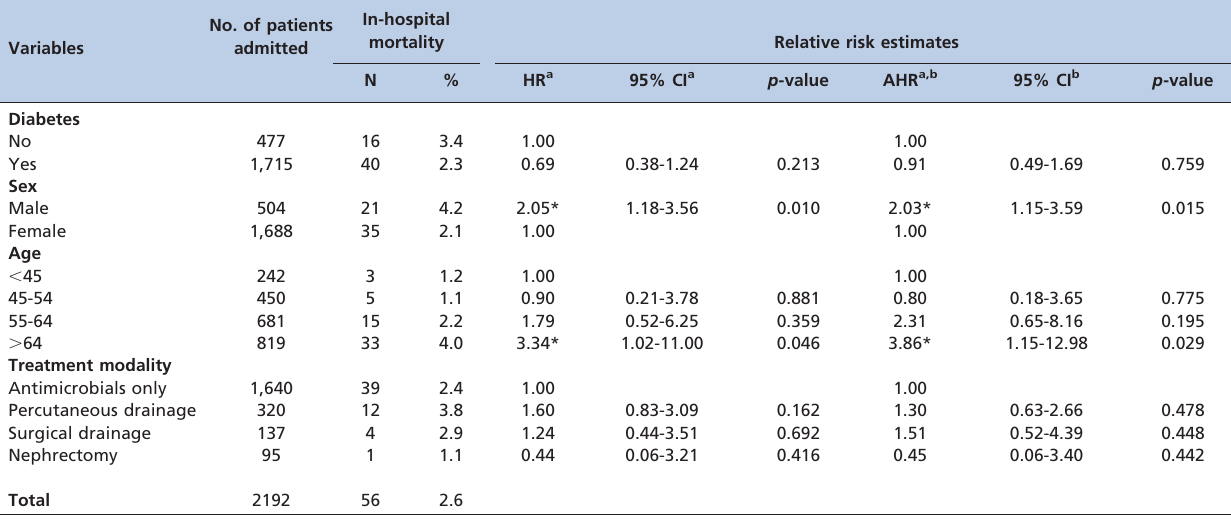
Table 2 - Hazard ratio of in-hospital mortality relative to diabetes, age, sex, and treatment modality in patients with renal or perinephric abscess (n=